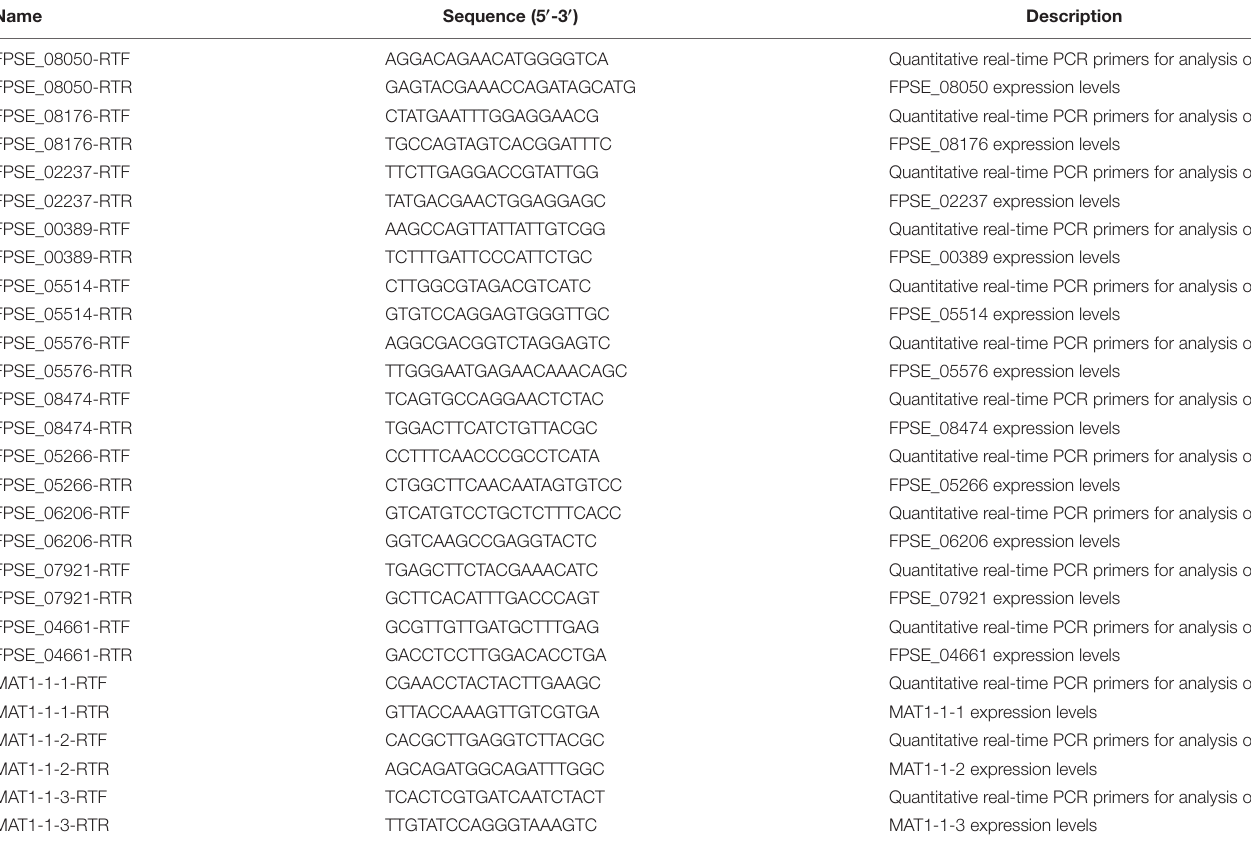
TABLE 1 | Primers used in the quantitative real-time